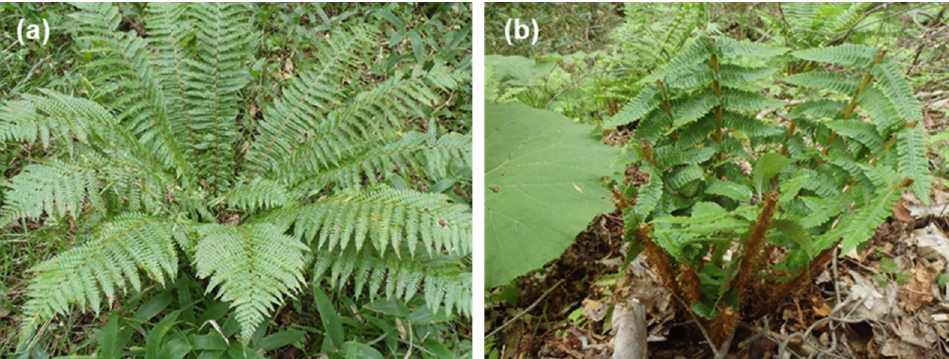
Figure 2. The arrangement of quadrat and subquadrats in each plot. Diameter at breast height (DBH), occurrence of debarking for all trees ≥ 1.5 m tall, and the number of broad-leaved seedlings 0.5–1.5 m tall and plant density, leaf length, and grazing intensity of Dryopteris crassirhizoma were recorded within plots. One 2 × 2 m quadrat was arranged in each plot randomly, and tree canopy photos and coverage and height of Sasa nipponica were recorded in each 1 × 1 m subquadrat.